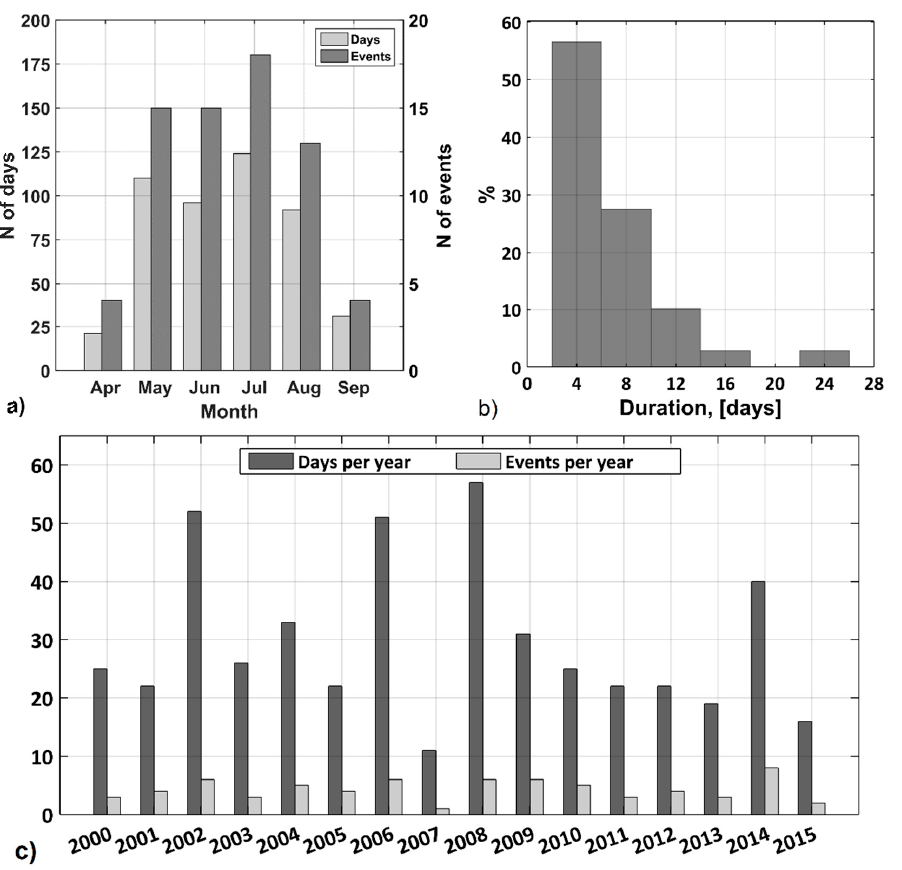
Figure 6. Upwelling season and duration in the SE Baltic Sea in 2000–2015: ( a ) Total number of upwelling events/days with upwelling per single month; ( b ) Histogram of upwelling duration; ( c ) Interannual changes of upwelling duration and frequency.